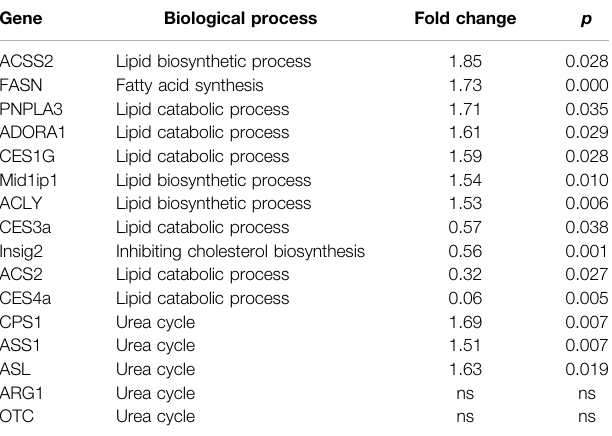
TABLE 2 | The lipid metabolism and urea cycle related genes altered in NFIB knock out liver. Gene Biological